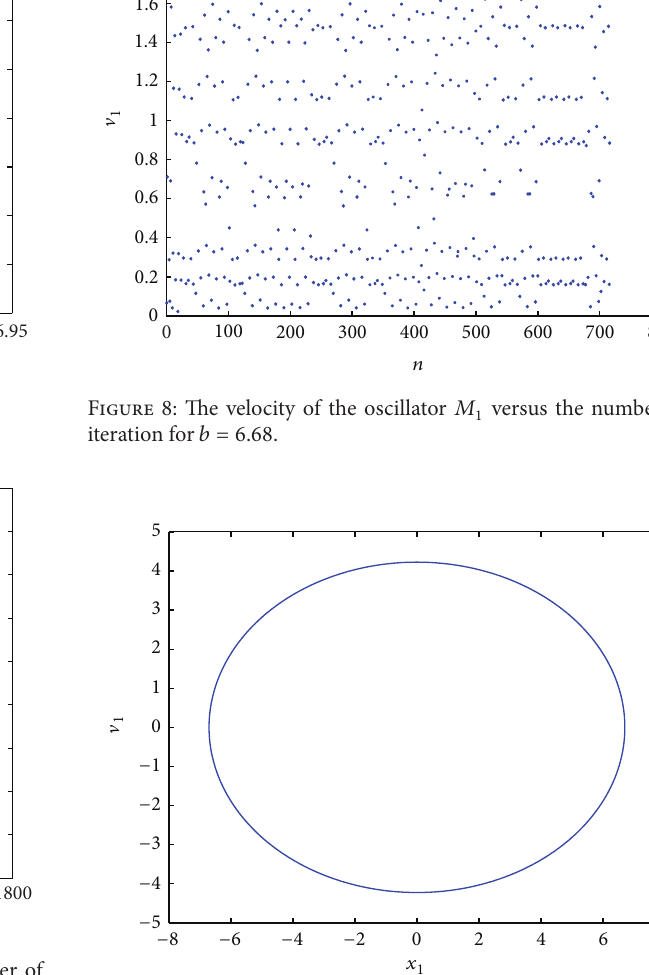
Figure 7: The velocity of the oscillator 𝑀 1 versus the number of iteration for 𝑏 = 6.69 .